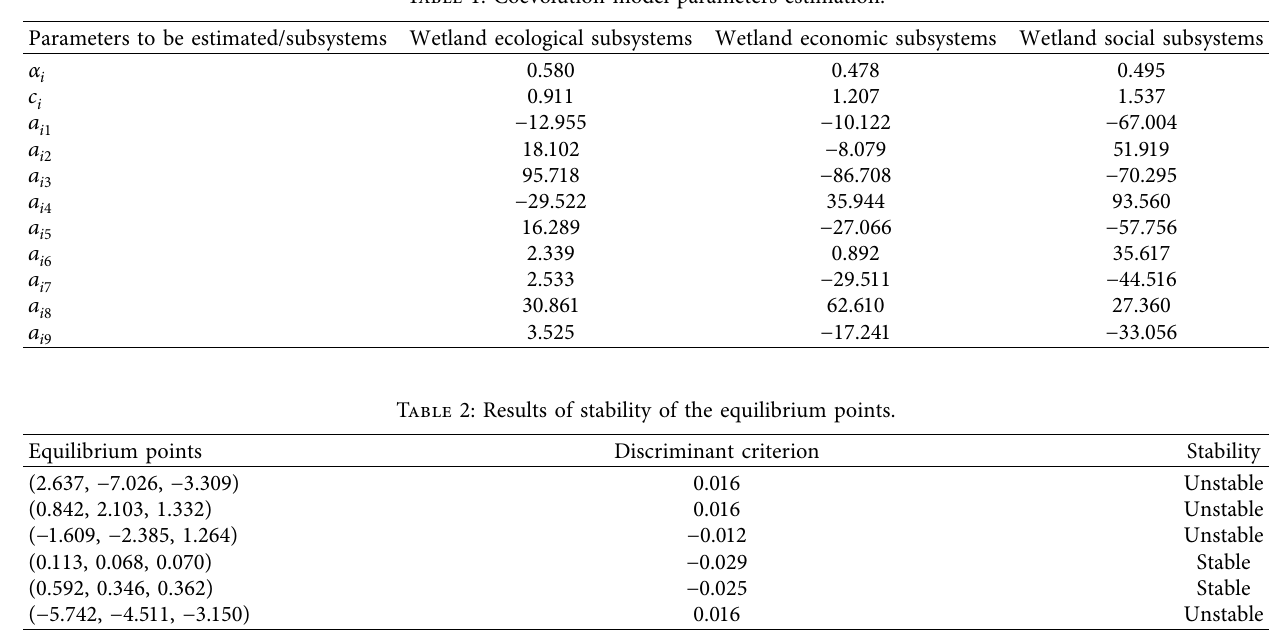
Table 1: Coevolution model parameters estimation.